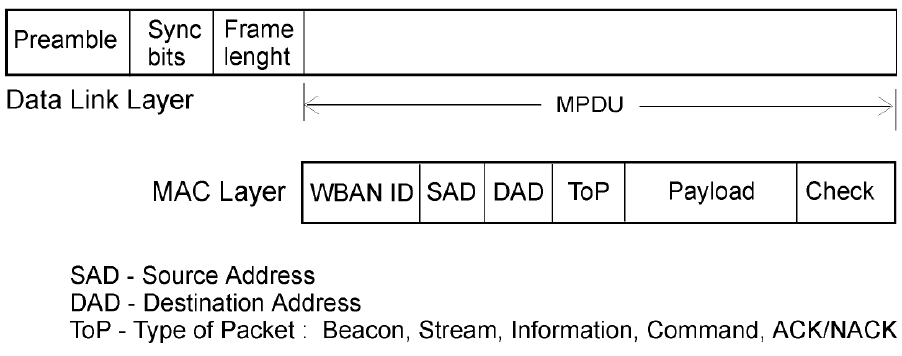
whMAC data packet: wake up command, beacon, data, status and ACK/NACK